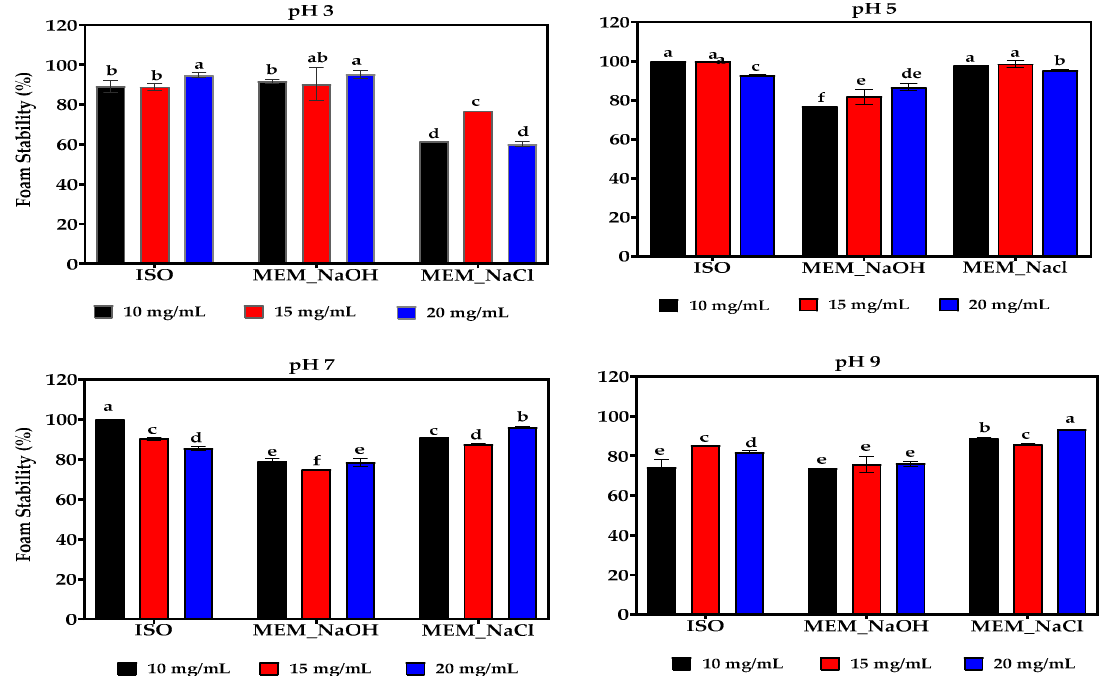
Figure 10. Effect of pH and protein concentration on the foaming stability of isoelectric pH precipitated isolate (ISO), and membrane isolated proteins from alkaline (MEM_NaOH) and salt (MEM_NaCl) solution extracts. At each pH, bars with different letters have significantly different ( p < 0.05) mean values.